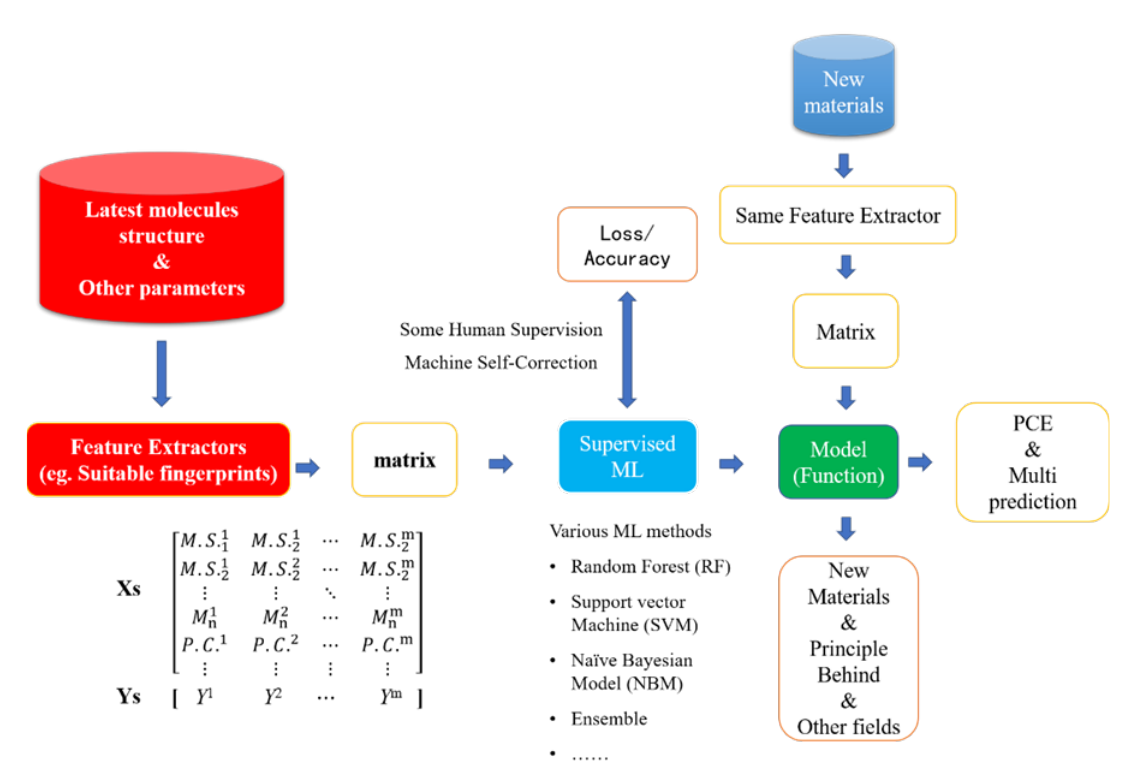
Figure 9. Possible directions and strategies in machine learning in OSCs where M.S. refers to molecular structure; M n refers to number-average molecule weight; P.C. refers to processing condition; and superscript indicates the index of data. Red boxes indicate the most important areas for material scientists.